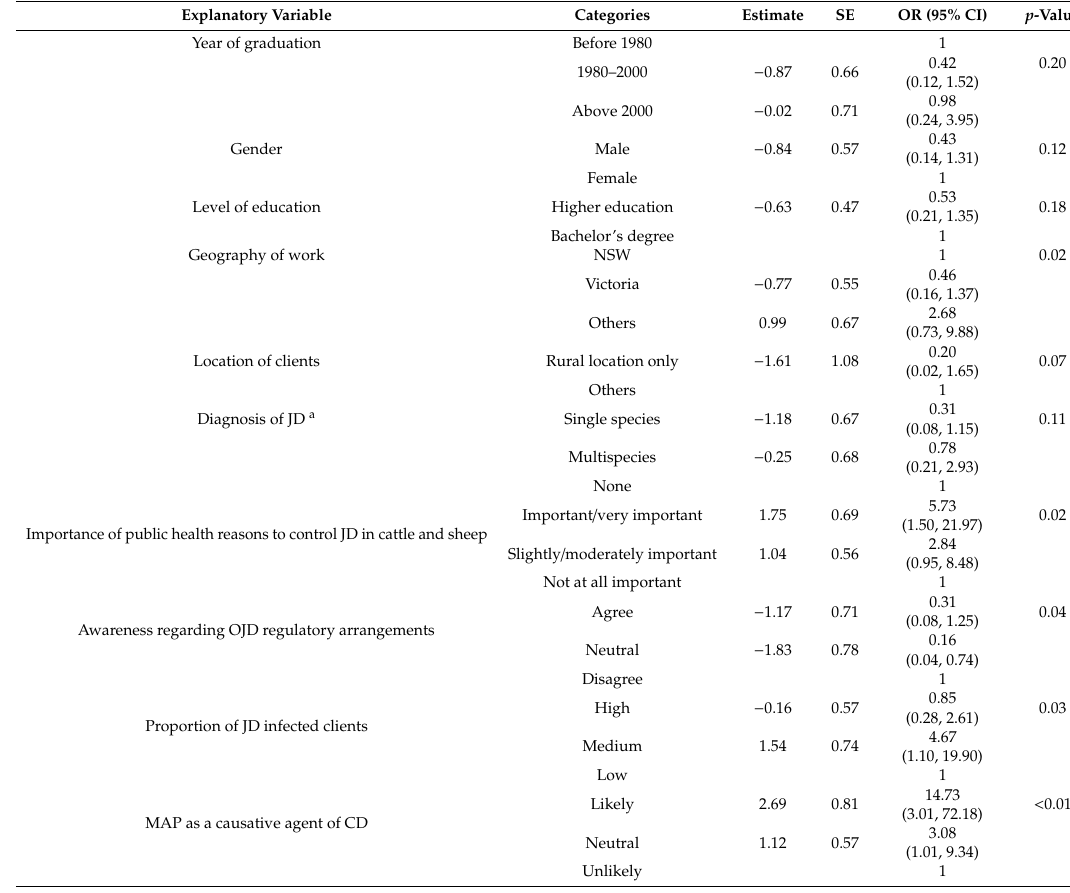
Table 6. Results of univariable binomial logistic regression analyses using consideration of veterinarians for adoption of ‘precautionary principle against Johne’s disease’ as an outcome based on a study conducted in Australia in